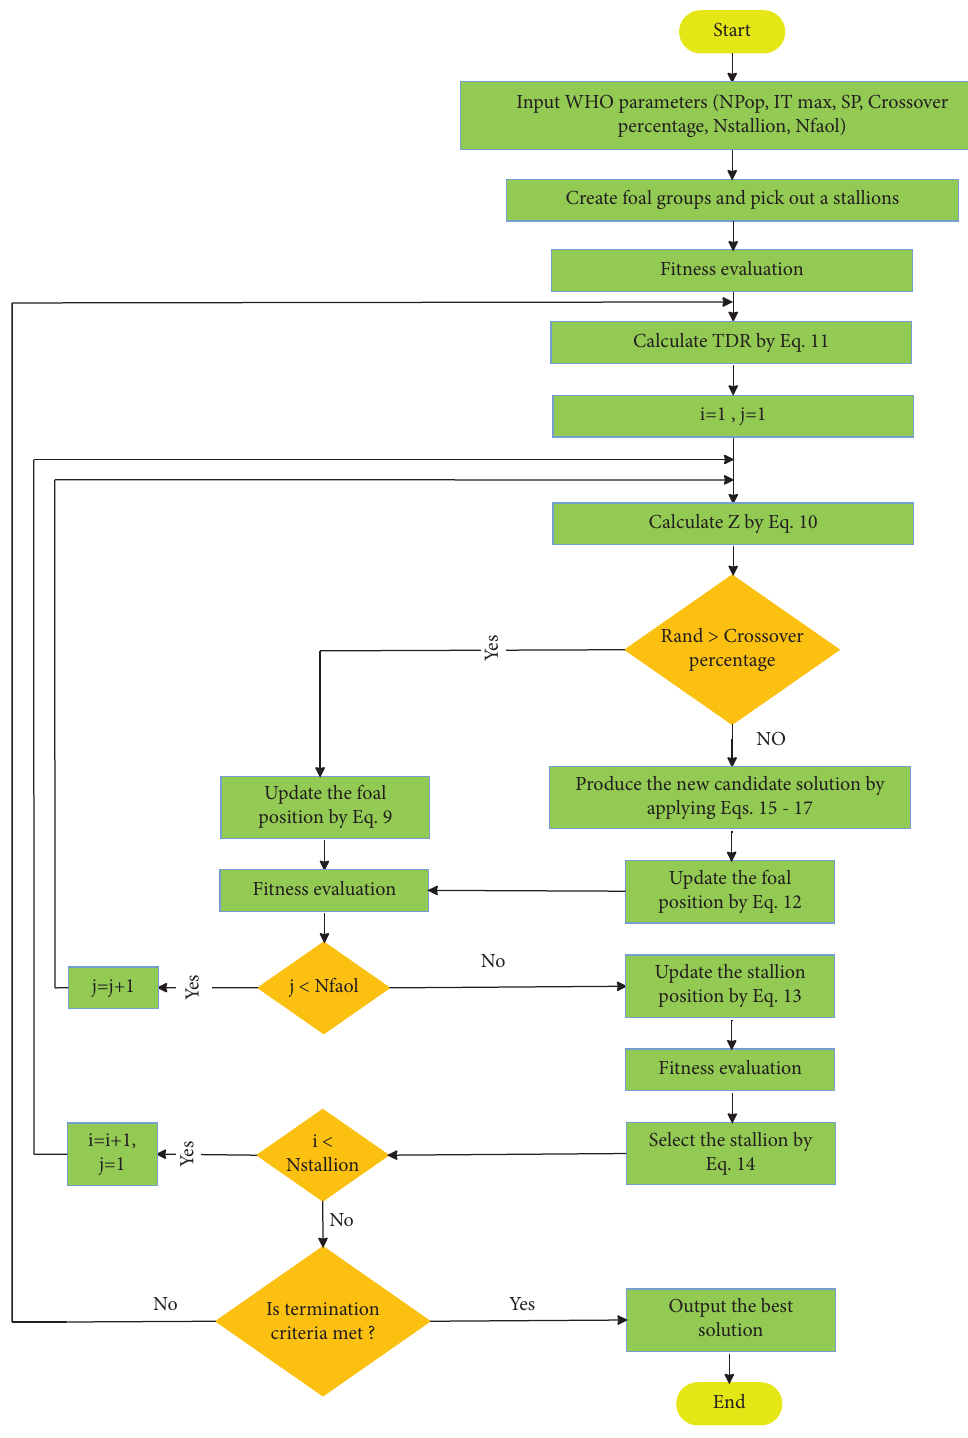
Figure 3: Flowchart of IWHO